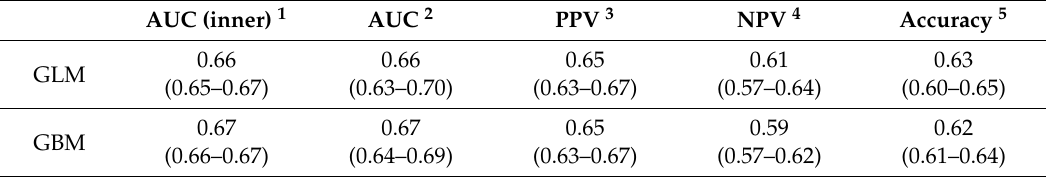
Table 4. Prediction performances for logistic regression (GLM) and stochastic gradient boosting (GBM). In parentheses 95 percent confidence intervals. Positive class